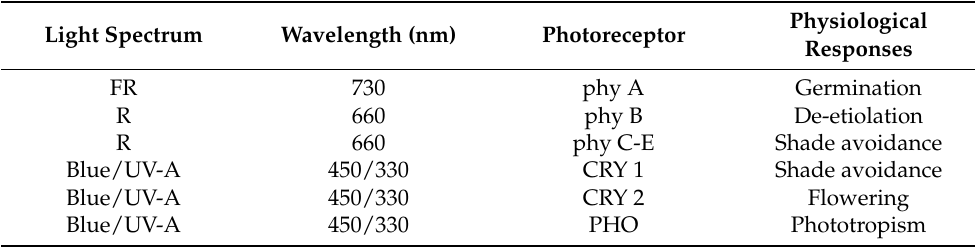
Table 2. Summary of photoreceptors involved in physiological responses of plants to different light spectra.